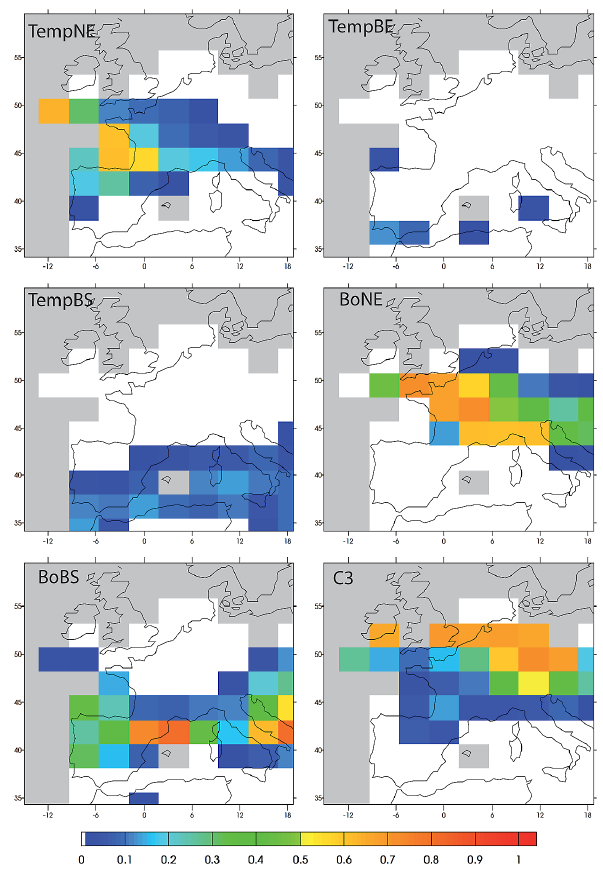
Fig. 9. Fractions of grid cells occupied by the different PFTs (annual maximum, between 0 and 1) simulated by ORCHIDEE in ON ctrl over Western Europe. The values are averages over the last 500yr of the run. PFT acronyms: see Table 1. Grey areas are occupied by ocean or ice